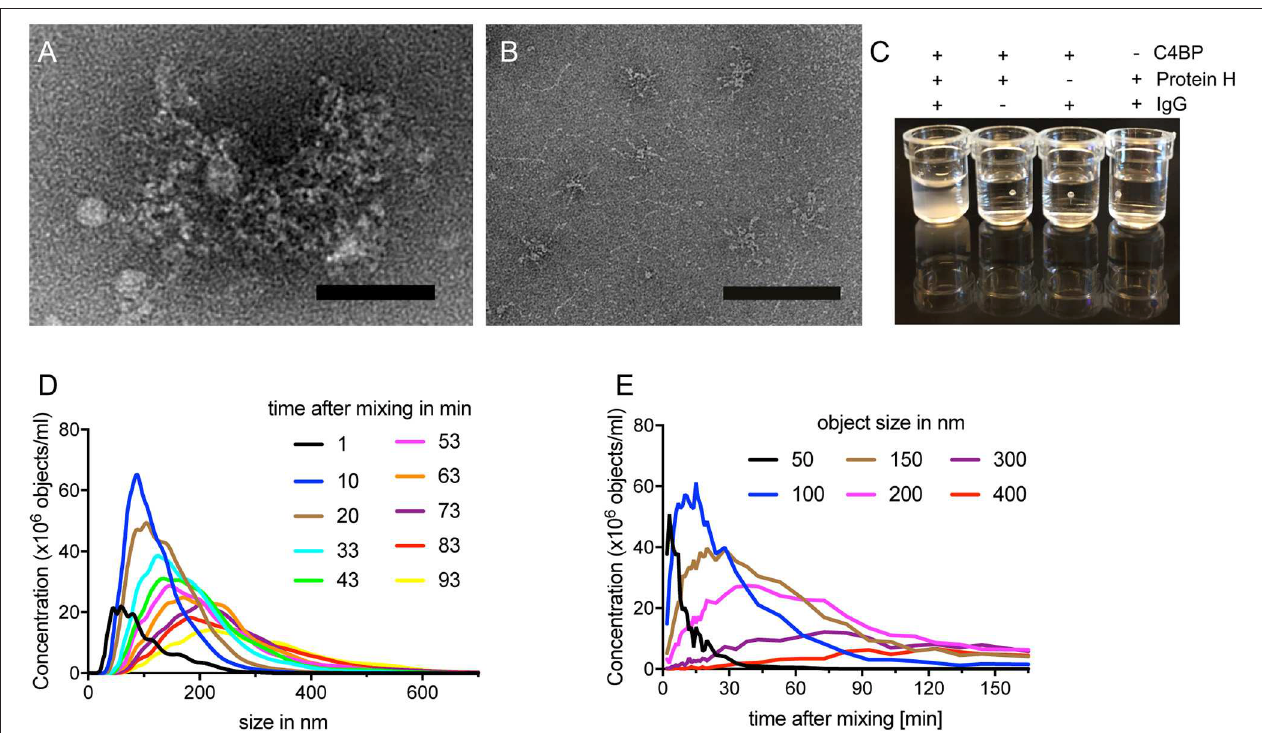
FIGURE 2 | C4BP, Protein H and IgG form large complexes in vitro . (A) Electron microscopy images of negative stained protein complexes formed between IVIG, Protein H and C4BP or only C4BP and Protein H (B) . (C) Protein H together with C4BP and IgG forms large complexes in solution, which are visible macroscopically. C4BP, IgG and Protein H were co-incubated for indicated time and analyzed by nanoparticle tracking analysis (NTA) to estimate complex size at a given time (D) or the concentration change of object size over time (E) . Bars indicate 50nm. Representative experiments of at least 3 repeats are shown.